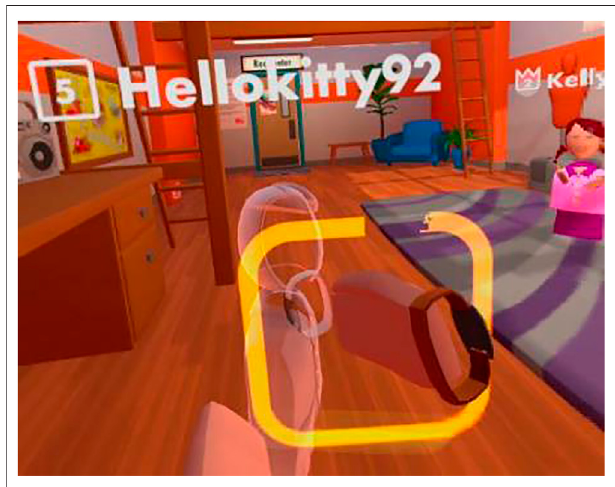
FIGURE 3 | Handshaking in RecRoom.